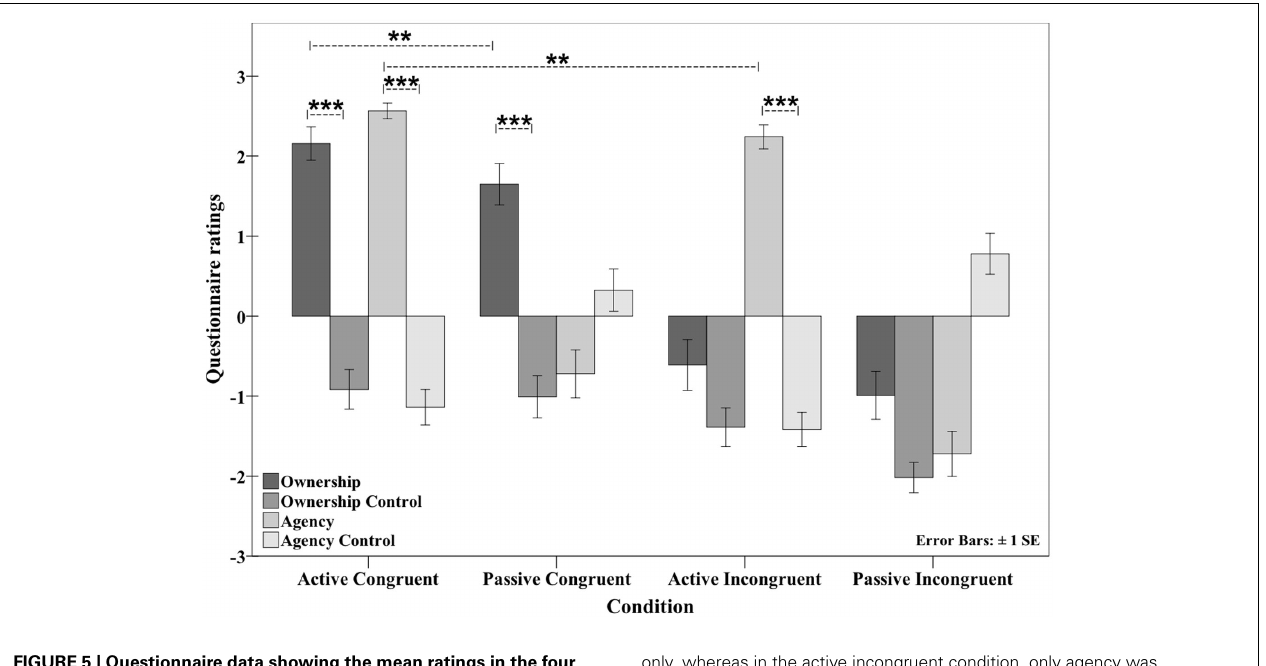
FIGURE 5 | Questionnaire data showing the mean ratings in the four conditions. The mode of movement (active versus passive) and the position (congruent versus incongruent) were varied. A sense of both ownership and agency was observed in the active congruent condition. In the passive congruent condition, participants experienced ownership